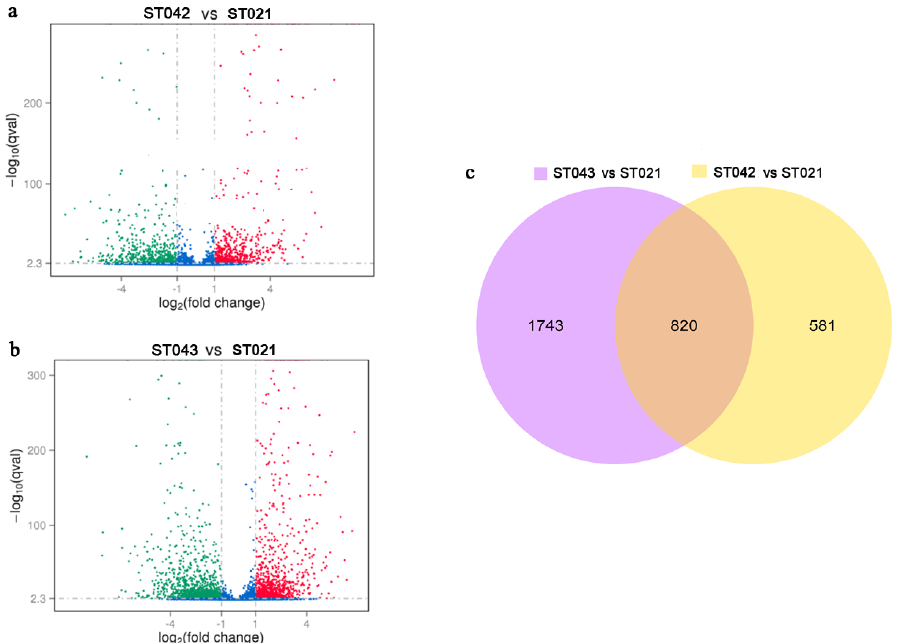
Figure 2 . The volcano plots and Venn diagram of differential expressed genes (DEGs) in strains ST021, ST042 and ST043. Volcano plots of ST042 vs. ST021 ( a ) and ST043 vs. ST021 ( b ). DEGs are shown in red (upregulated) and green (downregulated) points, while the others are shown in blue points. The horizontal axis represents the fold change of gene expression in different samples, while the vertical axis represents the statistical significance of gene expression difference. ( c ) Venn diagram of DEGs. Compared with ST021, the number of DEGs in ST043 is shown in the purple circle on the left, while that in ST042 is in orange circle on the right. The intersection of the two circles represents the number of DEGs shared by ST042 and ST043.